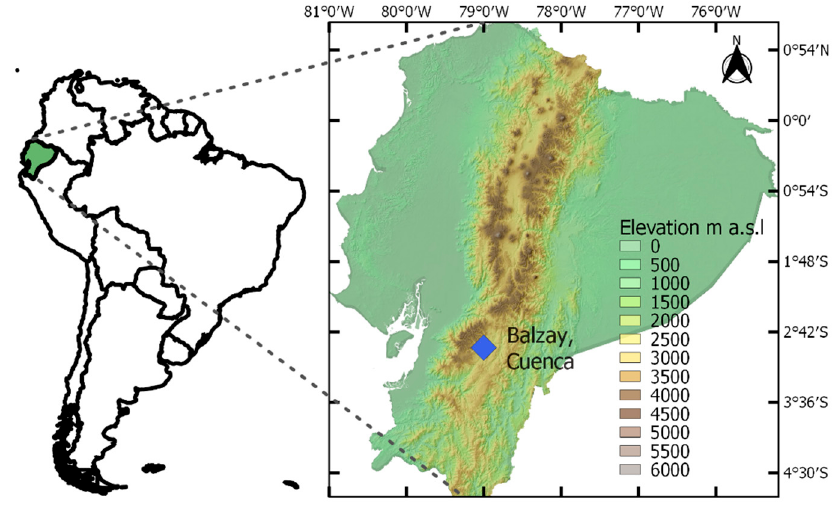
Figure 1. Study site in the southern Ecuador; the diamond indicates the location of instruments.